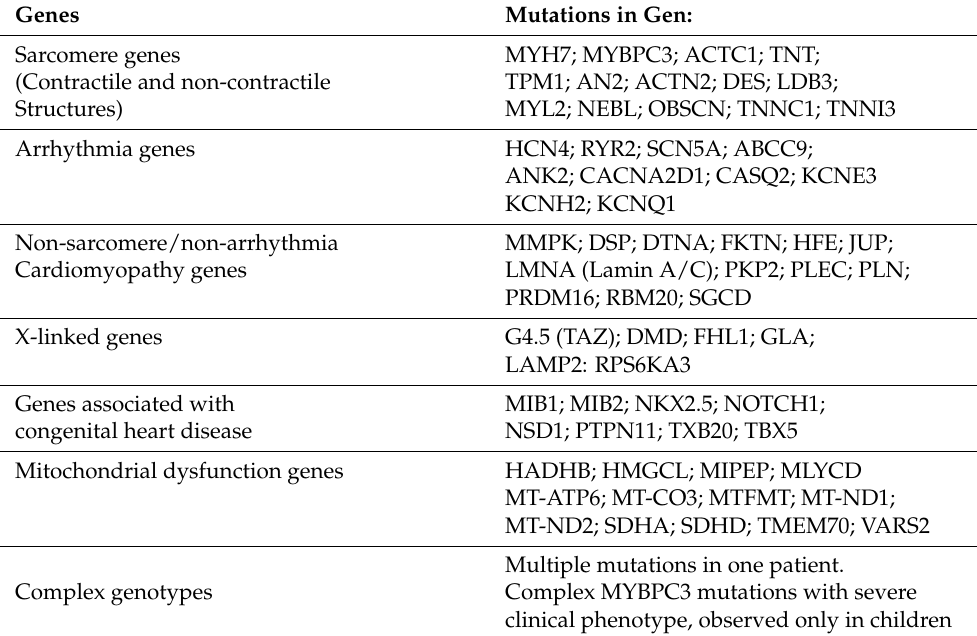
Table 7. Genes involved in different forms of noncompaction